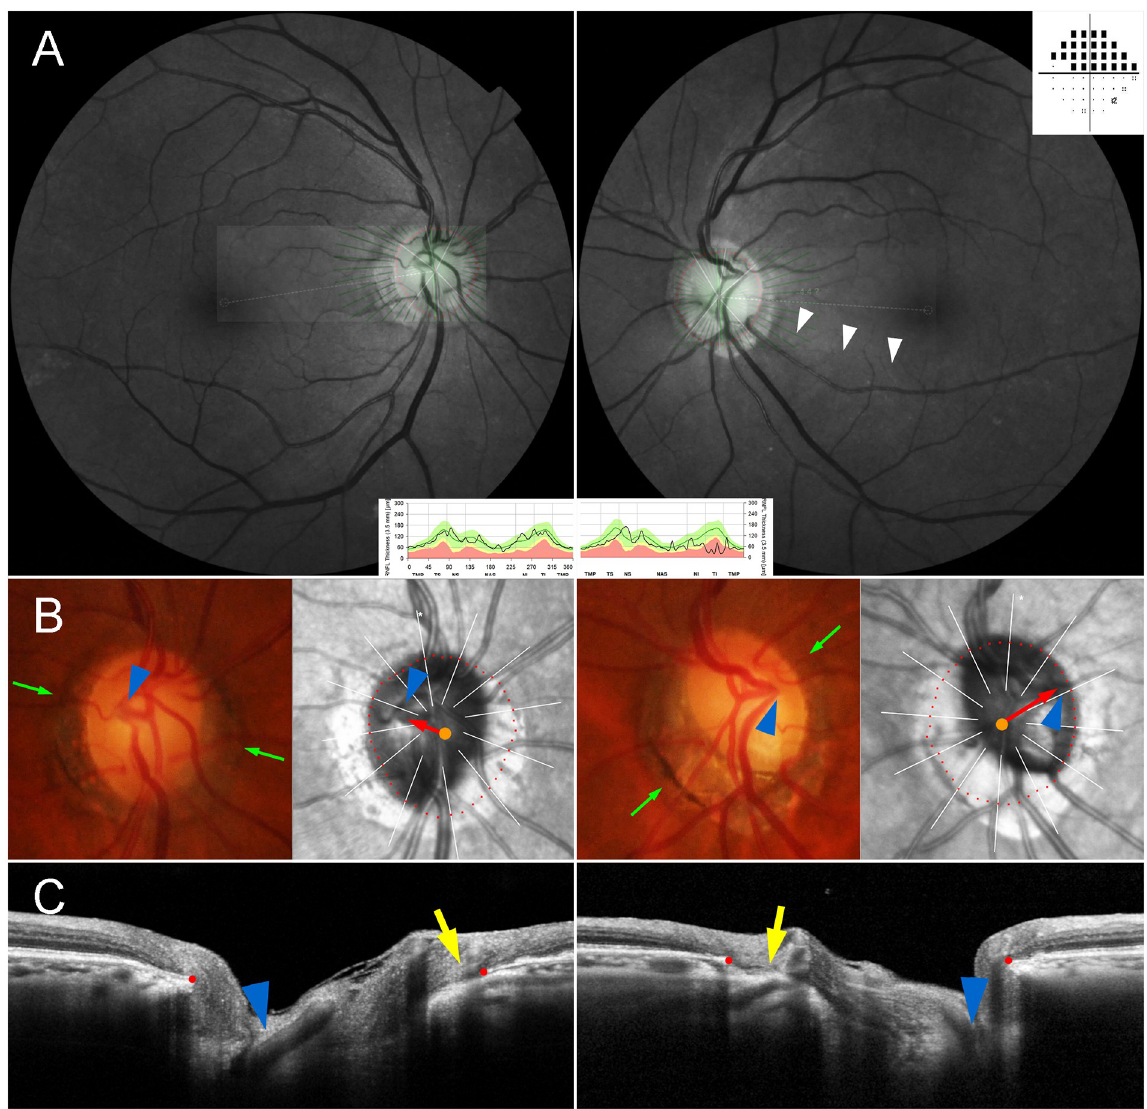
Fig 4. Inter-eye comparison of central retinal vascular trunk (CRVT) positions located on temporal side. ( A ) Red-free fundus photos and Humphrey visual field results. The infrared funduscopic spectral-domain (SD) OCT image is transposed to show the Bruch’s membrane opening (BMO) margin (red dots). The red-free fundus photos show inferior retinal nerve fiber layer (RNFL) defect in the left eye only (white arrowheads). The Humphrey visual field results show superior scotomas corresponding to the RNFL defect. Circumpapillary RNFL thickness maps, as measured by SD-OCT, are given at the bottom for comparison. ( B ) Disc photographs and infrared fundus images. The red dots indicate the BMO margin. The orange dots indicate the centers of the BMO. The arrowheads indicate the CRVT. The green arrows indicate the locations of the SD-OCT scans. Please note the larger offset in the glaucoma eye (red arrows). ( C ) B-scan SD-OCT images show emergence of CRVTs (arrowheads). Please note the larger offset in the glaucoma eye as evidenced by the position of the CRVT (arrowheads) and the difference of the externally oblique borders (yellow arrows) on the nasal